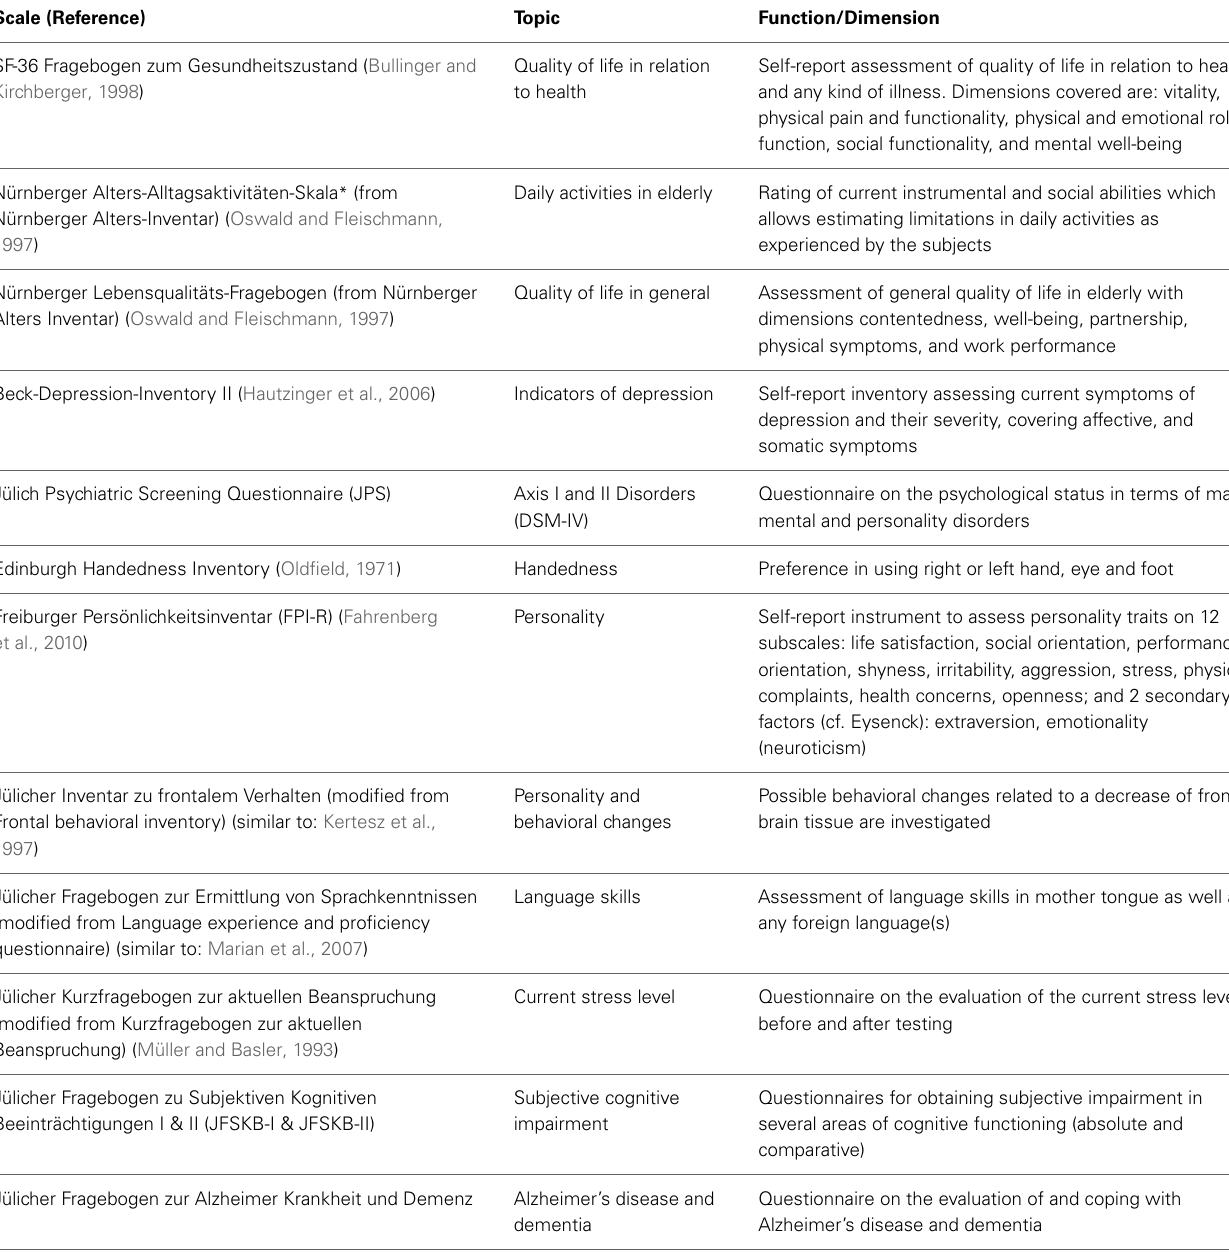
Table 3 | Neuropsychological self- and observer-based rating scales as used in